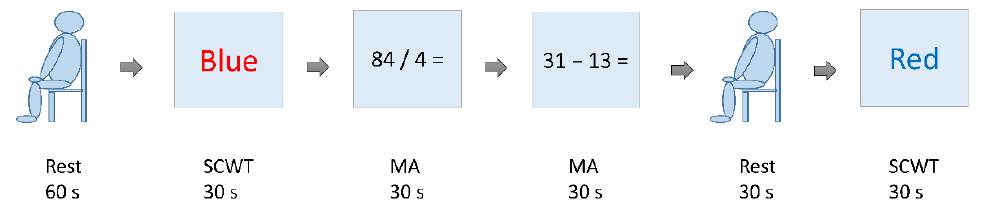
Figure 3. Diagram for the stress test.